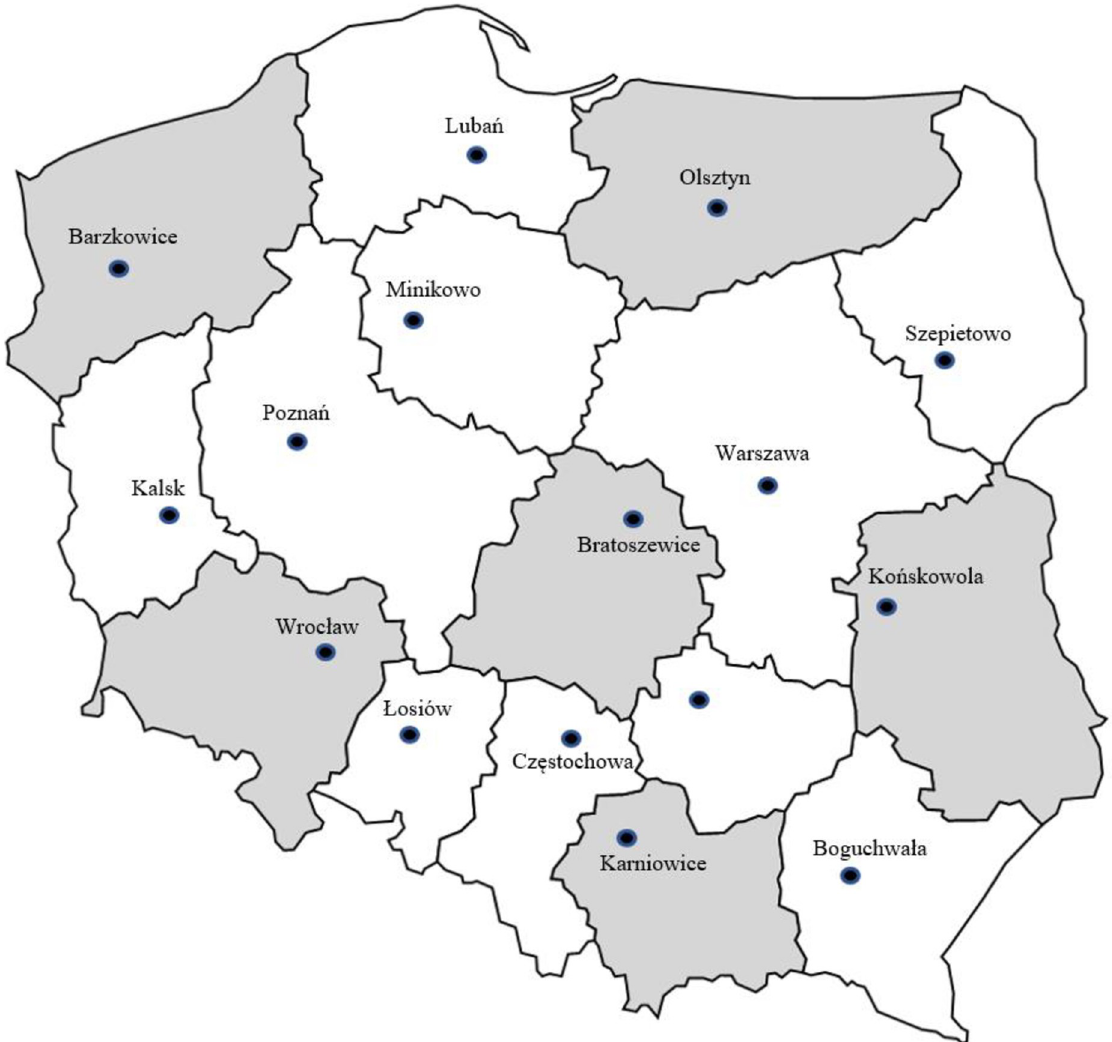
Fig 1. Seats of voivodeship agricultural advisory centres in Poland and location of the researched centres [42]. Source: Own elaboration base on